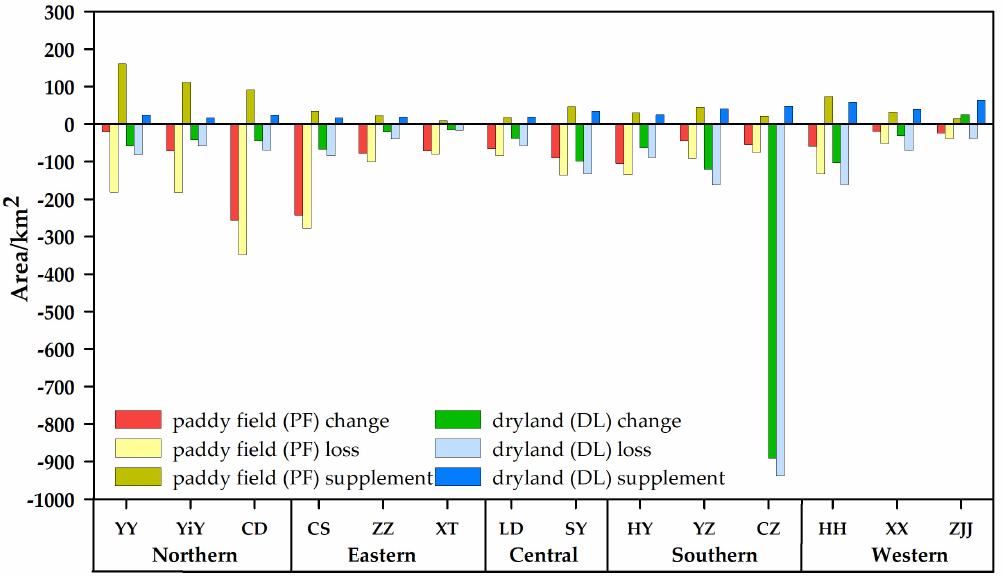
Figure 3. Changes in cultivated land of each city in Hunan Province from 1990 to 2014.